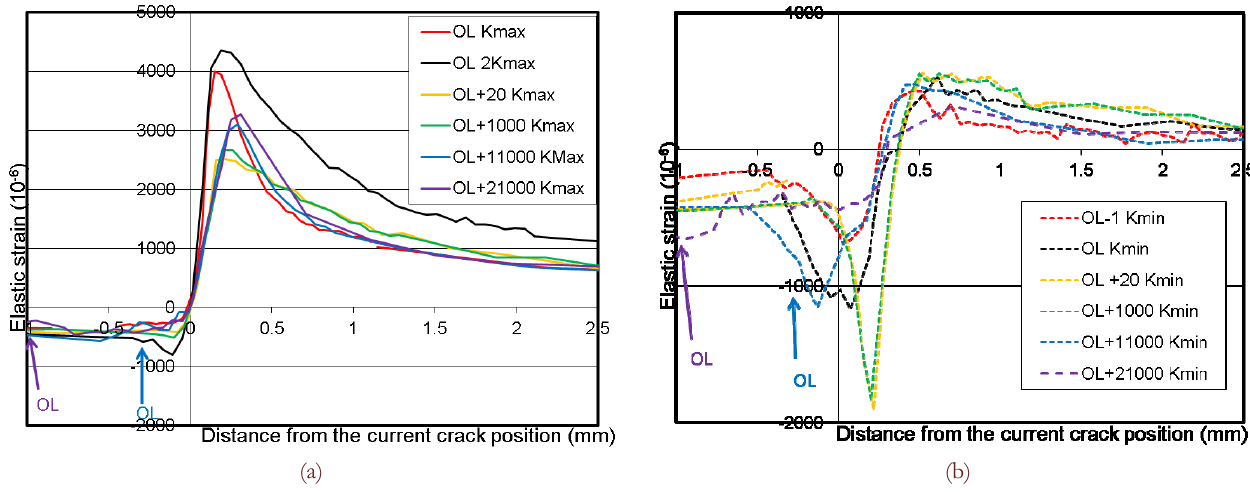
Figure 5: Strain evolution mid-thickness along the crack plane at a) K max and b) K min for all the stages of fatigue crack growth analysed. The coordinate along the crack plane (horizontal axis) has been corrected so that the crack-tip position coincides for all cases.